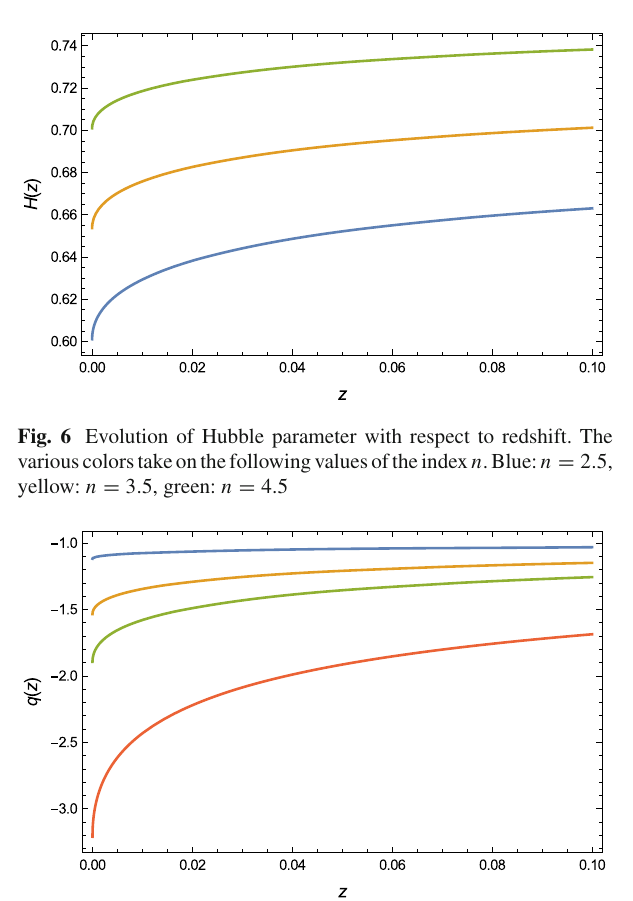
Fig. 5 Evolution of scale factor with respect to cosmic time. The various colors take on the following values of the index n . Yellow: n = 3, blue: n = 1 . 5, and green: n = − 0 . 5